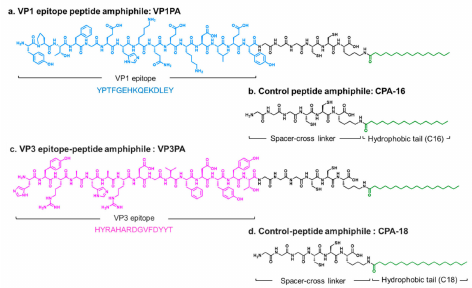
Figure 2. Structures of EV71 epitope peptide amphiphiles and control peptide amphiphiles. ( a ) EV71 VP1 epitope peptide amphiphile (VP1PA) and ( b ) control peptide amphiphile (CPA-16). ( c ) EV71 VP3 epitope peptide amphiphile (VP3PA), and ( d ) control peptide amphiphile (CPA-18).